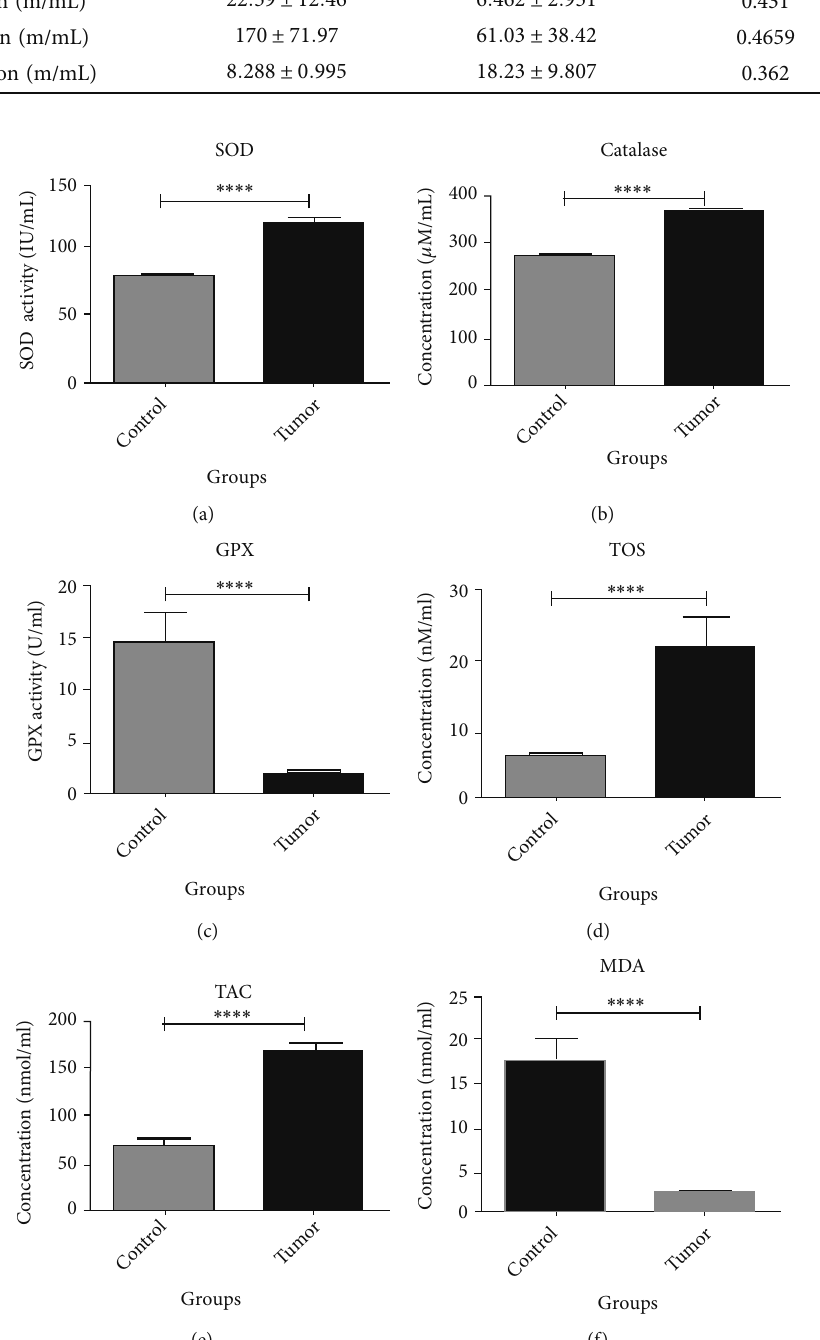
Figure 1: Comparsion of oxidative stress parameters beween cases and